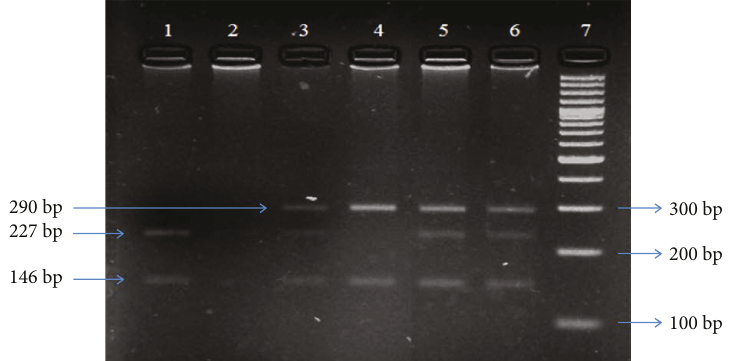
Figure 2: Representative gel showing Pst I-digested amplicons of XPD codon 751 run on 3% agarose gel. Lane 7: 100bp DNA ladder. Lane 4: 146bp and 290bp Lys/Lys genotype. Lanes 3, 5, and 6: 146 bp, 227bp, 290bp, and 63bp Lys/Gln genotype. Lanes 1 and 2: 146bp, 227bp, and 63bp Gln/Gln